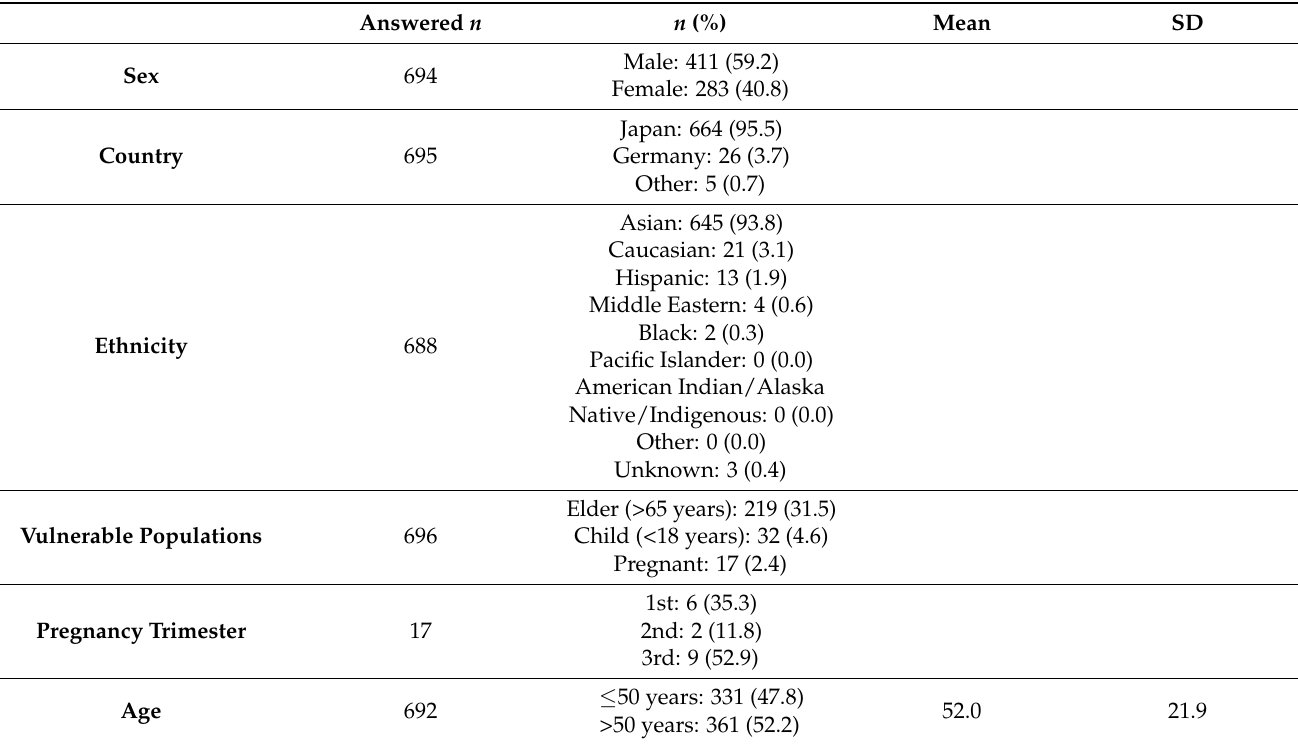
Table 1. Demographics of 696 patients in the COVID-19